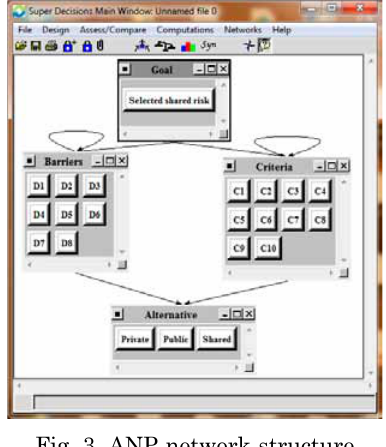
Fig. 3. ANP network structure